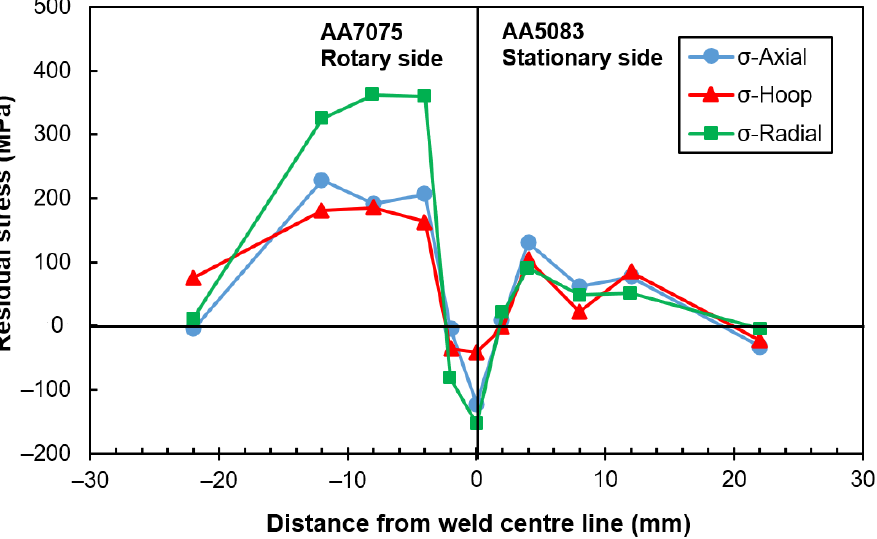
Figure 13. The residual stress distributions of rotary friction welded dissimilar AA7075/AA5083 joints produced at the rotational speed of 1200 rpm.